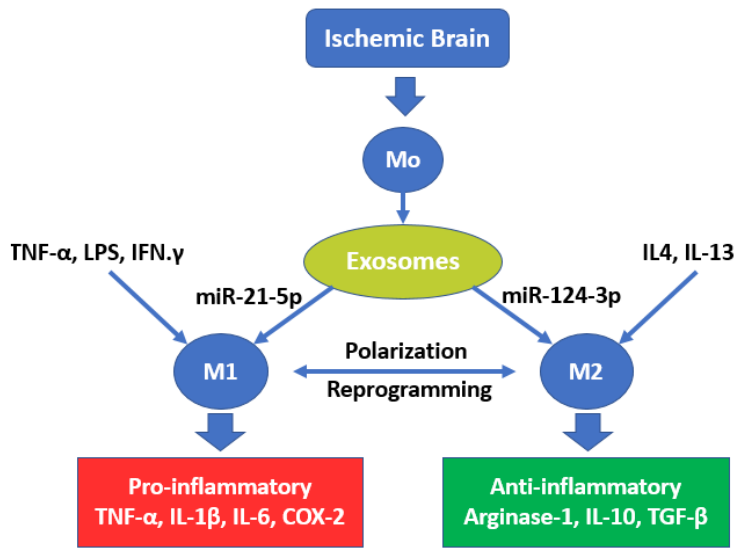
Figure 4. Microglia activation after